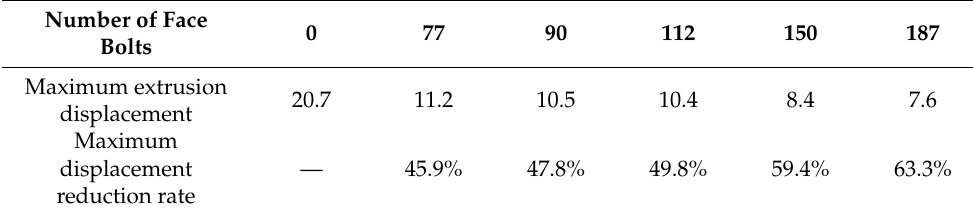
Table 9. Maximum displacement and reinforcement effectiveness of tunnel face.